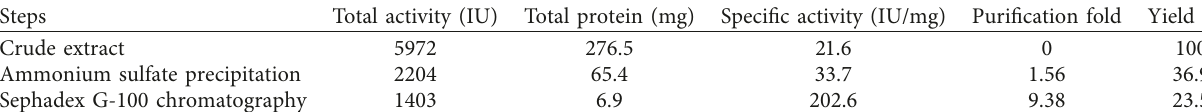
Table 1: Purification profile of isolated L-ASP.